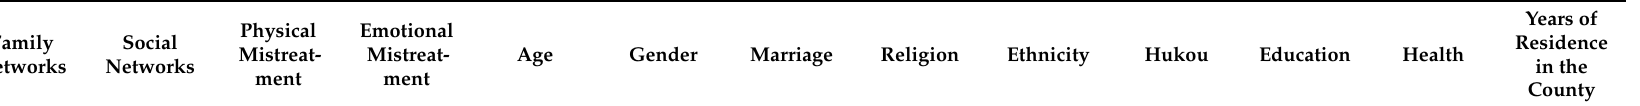
Table 1. Correlation